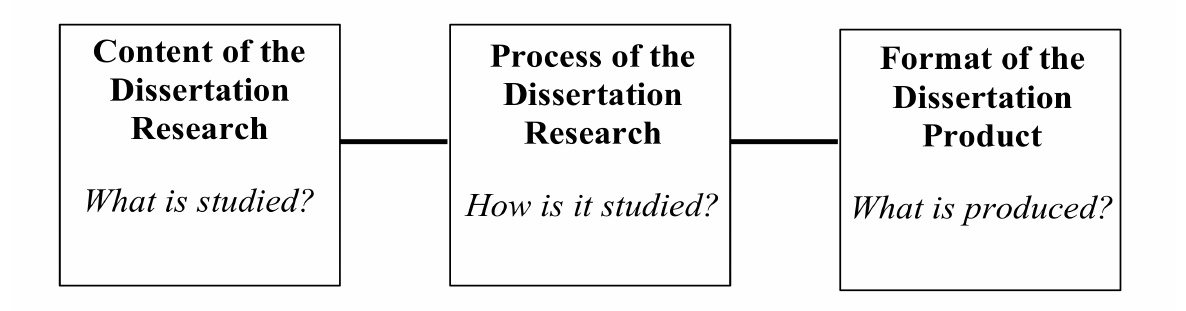
Figure 1. Components of the dissertation process shaped by programs’